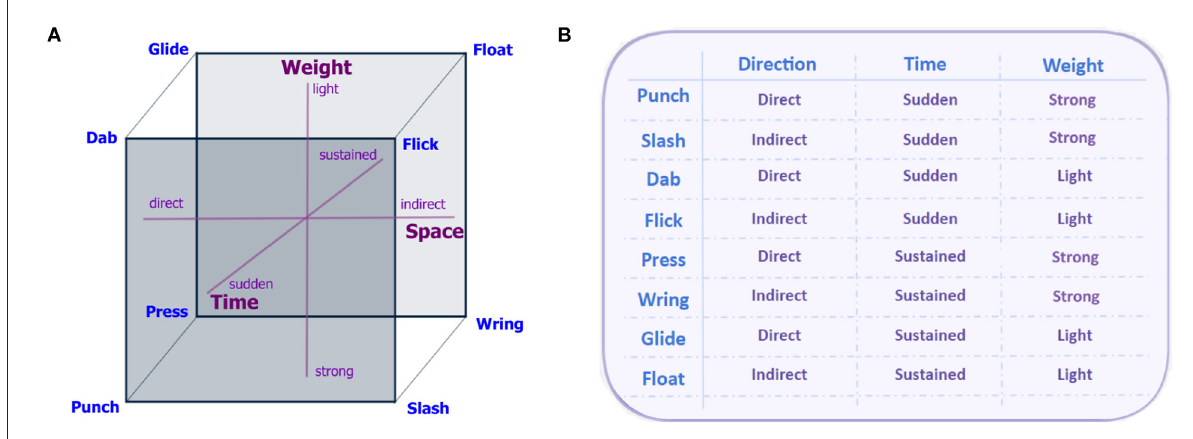
FIGURE1 Different presentations of Laban’s Basic Effort Actions. Panel (A) visualizes Laban’s Effort dynamosphere (Newlove and Dalby, 2004) and panel (B) lists Laban’s Eight Basic Effort Actions.